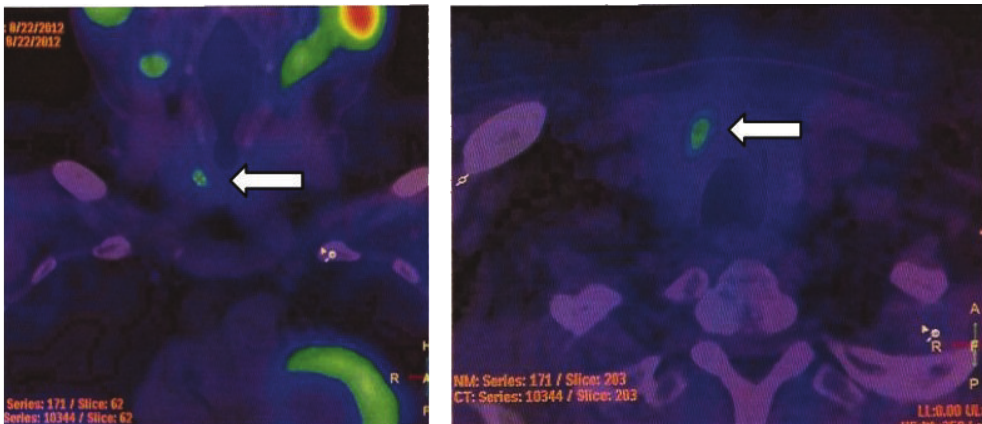
Figure 1: Parathyroid Tc99m-MIB scintigraphy. Images showed an increased uptake of the right superior parathyroid gland on the 150min delayed image compared with the early 15min image (white arrow).